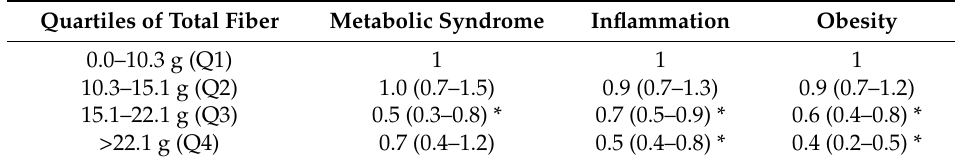
Table 4. Adjusted odds ratios for cardiometabolic risk factors, based on quartiles of dietary fiber intake in four countries across the epidemiologic transition 1